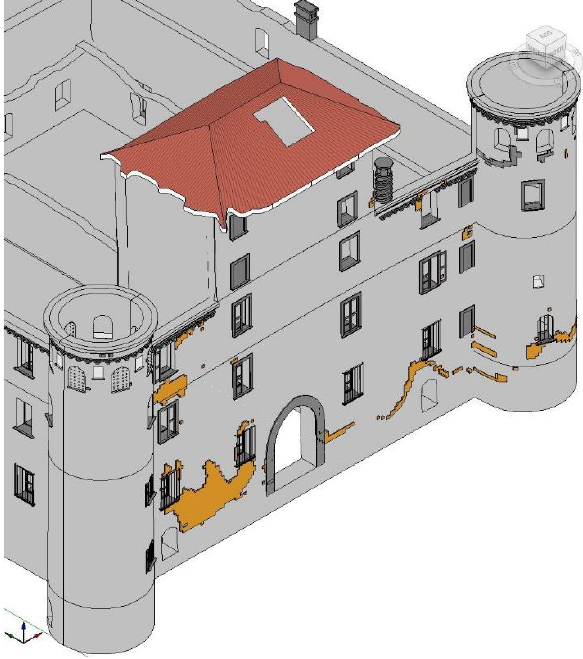
Figure 16. Revit environment: surfaces imported as a wall building component in the BIM